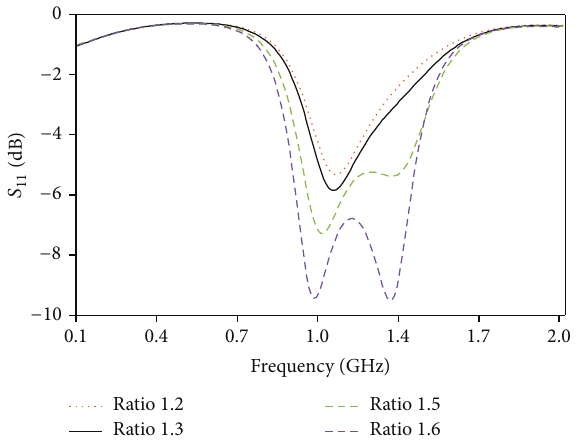
Figure 2: S 11 response for the change in radius ratio of the inner elliptical shape of the annular ring at patch.